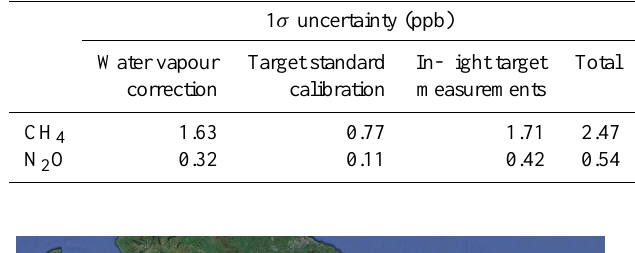
Table 2. The fraction of 1Hz data within the WMO compatibil- ity recommendations for QCLAS target cylinder measurement and QCLAS–FGGA sample measurement, using both the original and pressure-differentiated calibration methods.